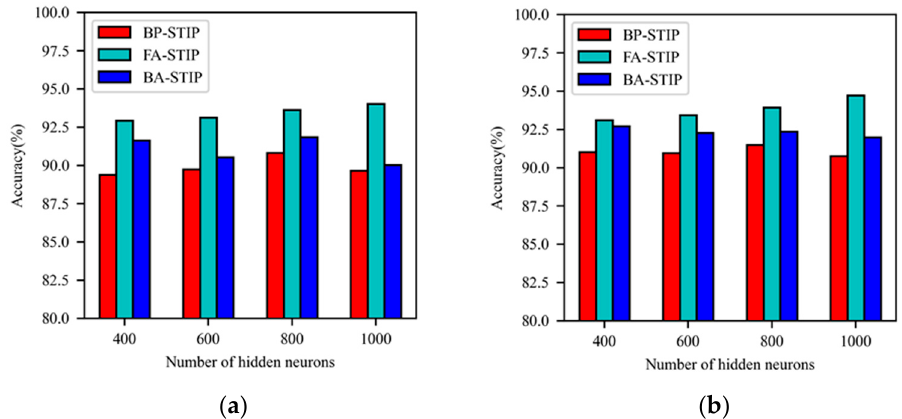
Figure 5. Comparison of learning performance for three STIP ‐ based algorithms with Gaussian ker ‐ nel function. ( a ) The accuracy of the training set; ( b ) the accuracy of the testing